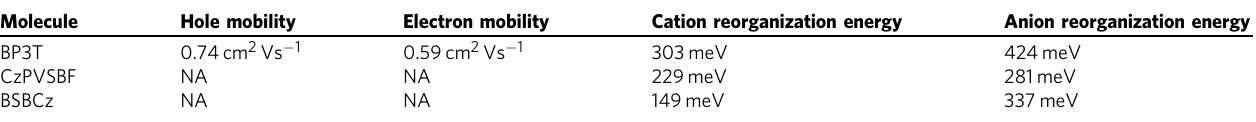
Table 5 Hole/electron mobility and cation/anion reorganization energy for BP3T, CzPVSBF, and BSBCz.